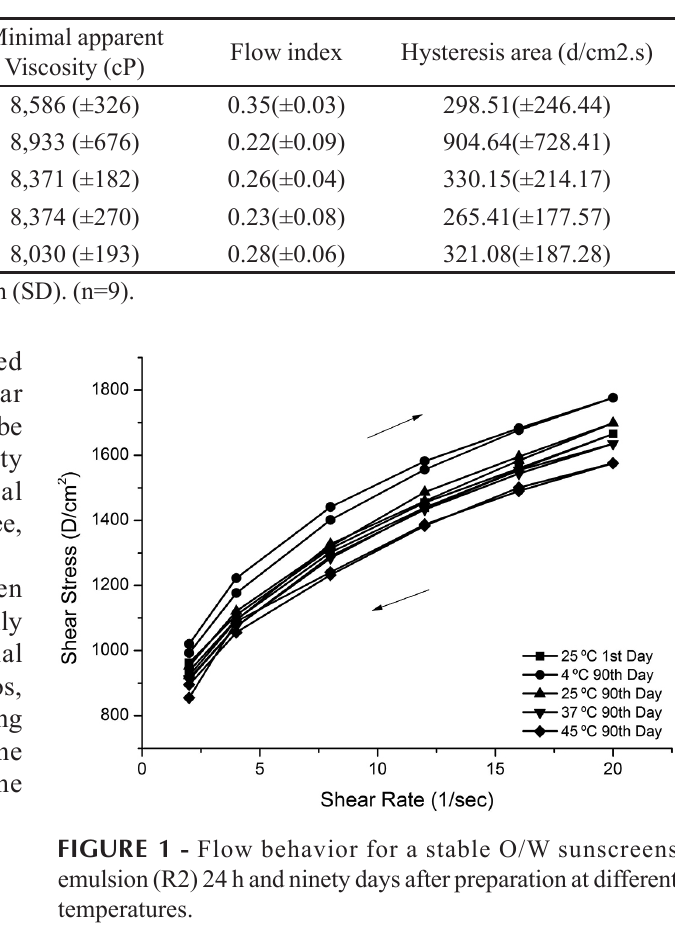
TABLE III - pH value, minimal apparent viscosity, flow index and hysteresis area values of O/W emulsion (R2) during accelerated stability studies at different temperatures